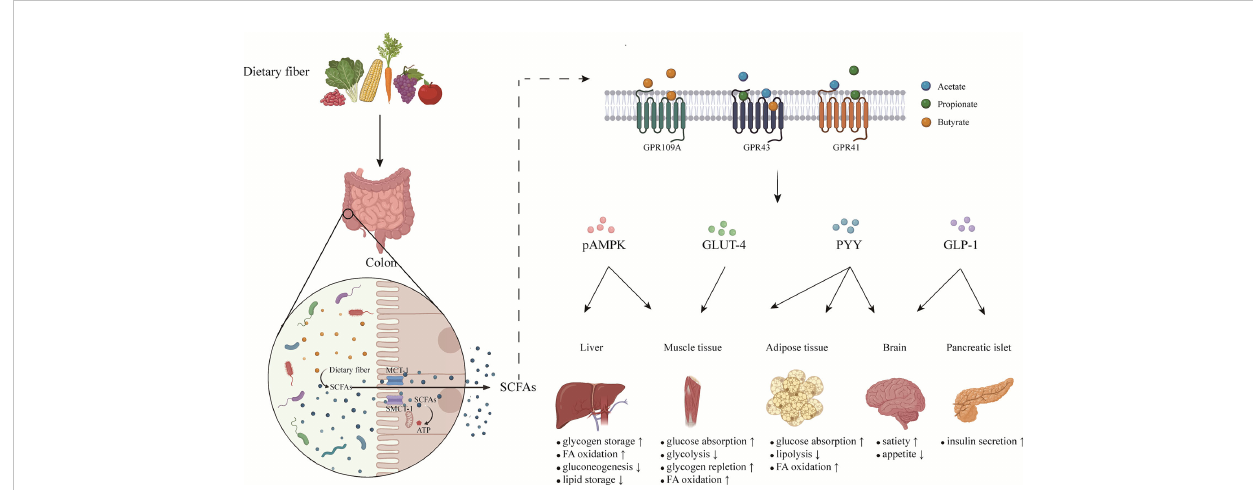
FIGURE 1 The effects of short chain fatty acids on metabolic homeostasis. SCFAs are produced by gut microbiota fermenting soluble dietary fi ber in colon. Most SCFAs are absorbed by colonocytes via MCT-1 and SMCT-1, while small part of SCFAs pass directly through the intestinal barrier by passive diffusion. SCFAs transported to various organs of the whole body exert different functions mainly by binding with GPCRs on cells. By coordinating various organs and systems, SCFAs regulate energy balance and maintain metabolic homeostasis. SCFAs, short chain fatty acids; MCT-1, monocarboxylate transporter 1; SMCT-1, sodium-coupled monocarboxylate transporter 1; GLP-1, glucagon-like peptide-1; PYY, peptide tyrosine tyrosine; pAMPK, phosphorylated adenosine monophosphate activated protein kinase; GLUT-4, glucose transporter-4; FA, fatty